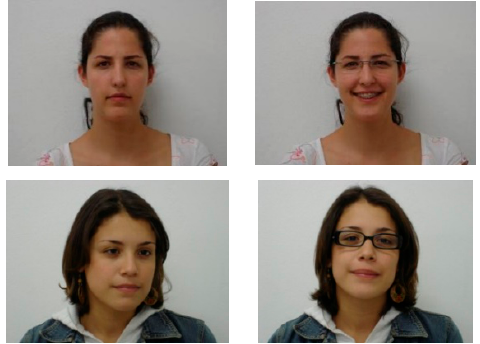
Figure 17. Images of people with and without glasses.